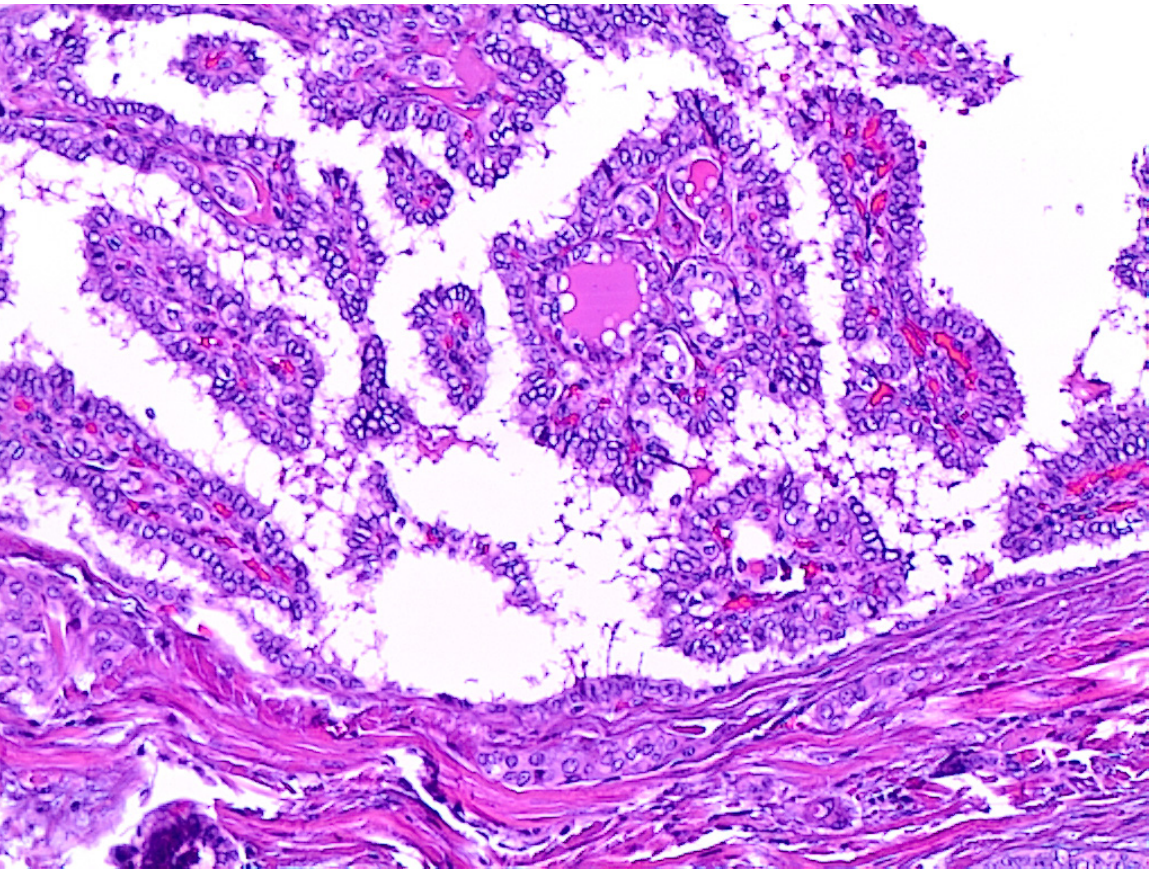
Figure 6. Details from a locally advanced thyroid carcinoma with a columnar cell variant of PTC component (200×,